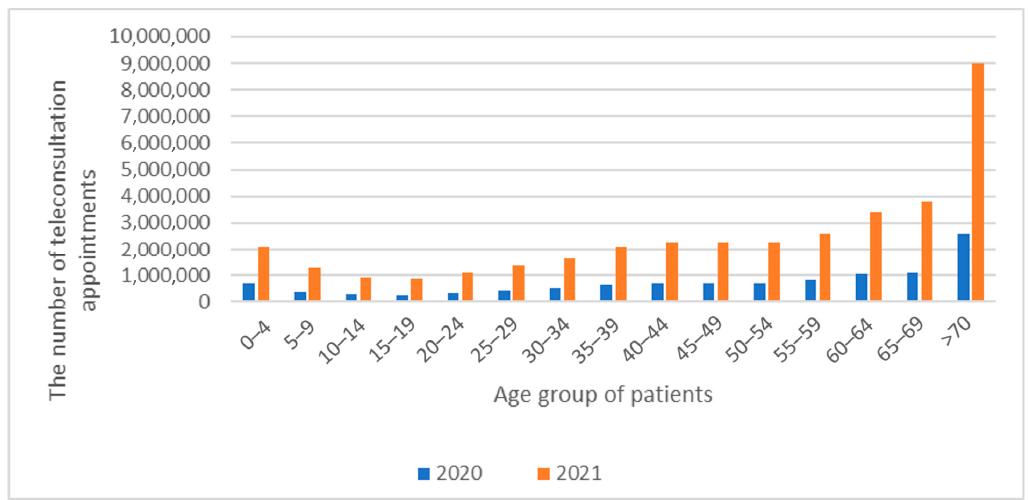
Figure 2. The distribution diagram of the served PCTs in 2020–2021, in age groups.